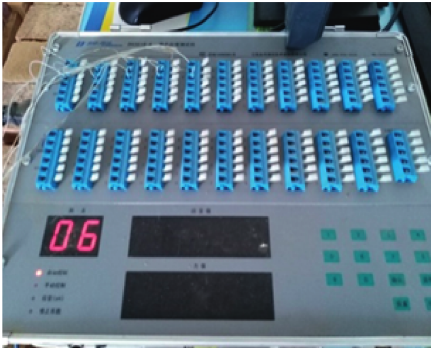
Figure 12: Static strain tester in work.